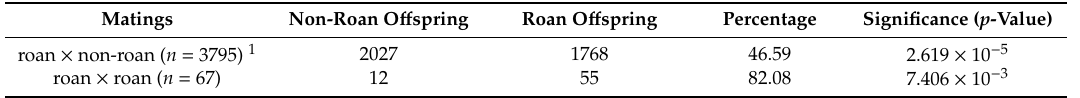
Table 1. Matings of roan × non-roan ( ≥ 2 o ff spring) and roan × roan. Significance was calculated using a Chi-Square test. Matings Non-Roan O ff spring Roan O ff spring Percentage Significance ( p -Value) roan × non-roan ( n = 3795) 1 2027